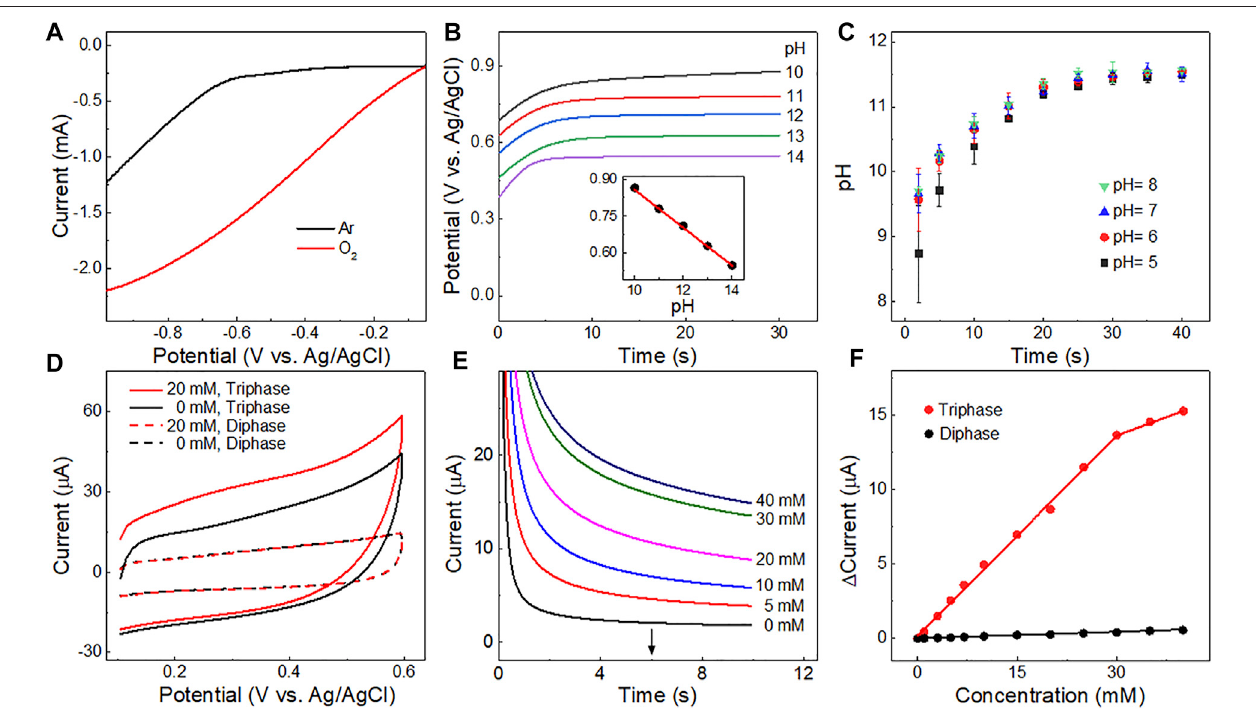
FIGURE 3 | (A) Linear sweep voltammetry curves of the Pt detection electrode in Ar and O 2 saturated 0.10 M Na 2 SO 4 solution. (B) Potentials of the detection electrode measured in solutions of different pH with a constant current (5 μ A). Inset is the linear relationship between potentials derived at 20 s and solution pH values. (C) Changes in pH valueovertimeatthedetectionelectrodeuponapplicationofapotentialof − 0.6 VattheOH − productionelectrodeinelectrolytewithdifferentpHvalues.Theerrorbarrepresents thestandarddeviationfortworeplicatedmeasurements. (D) Cyclicvoltammetrycurvesobtainedina0.1 MNa 2 SO 4 solutionwithorwithout20 mMglucoseusingatriphase ordiphasePt-PtelectrodeaftertheOH − productionstep. (E) Amperometrici-tcurvescorrespondingtothetriphasePt-Ptelectrodewithglucoseconcentrationsupto40 mM. (F) Corresponding calibration plots of triphase and diphase electrodes derived from (E) and Supplementary Figure S5 at 6 s Δ Current = Current s - Current 0 ; Current 0 is the background current; and Current s is the current measured in the solution with different glucose